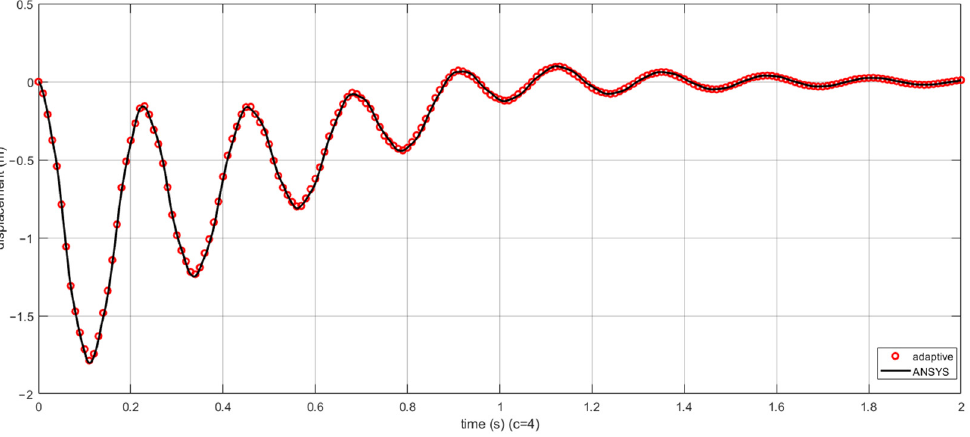
Figure 22. The transient vertical displacement at point A with damping ( c = 4 Ns/m) and ∆ t = 0.001 s under transient loading with finite decreasing time.